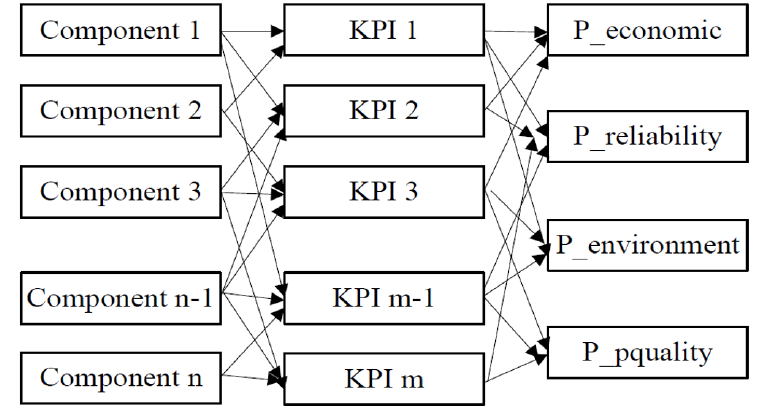
Figure 1. Interrelation between microgrid (MG) components and Key Performance Indicators (KPIs)